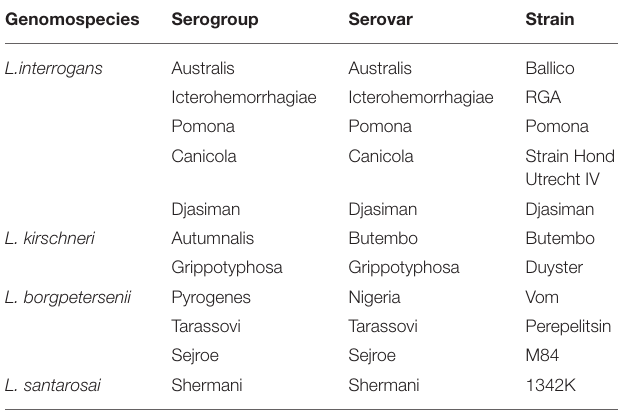
TABLE 1 | Strains of Leptospira species used as live antigens in the MAT. Genomospecies Serogroup